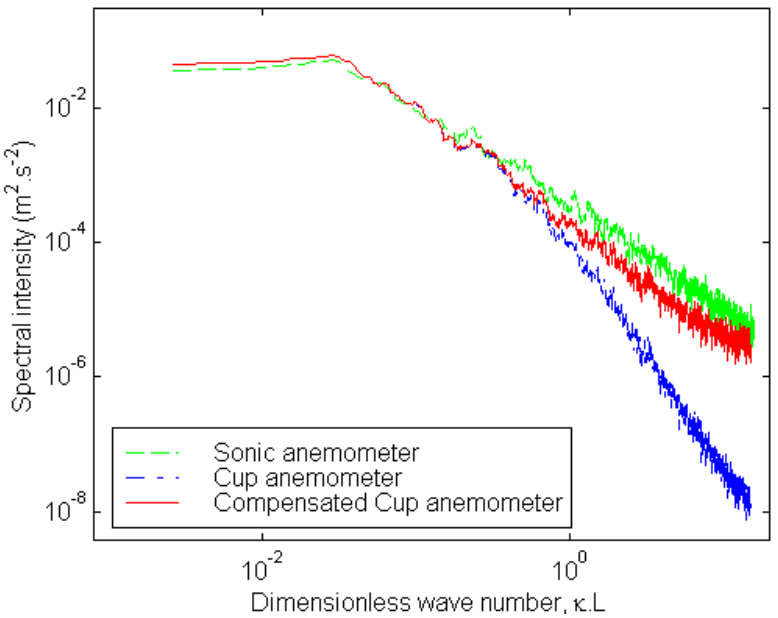
Fig. 5. Spectral intensities of the data from the ultrasonic and the cup anemometers. The third curve represents the compensated data of the cup anemometer. Sample 7 of 30 December